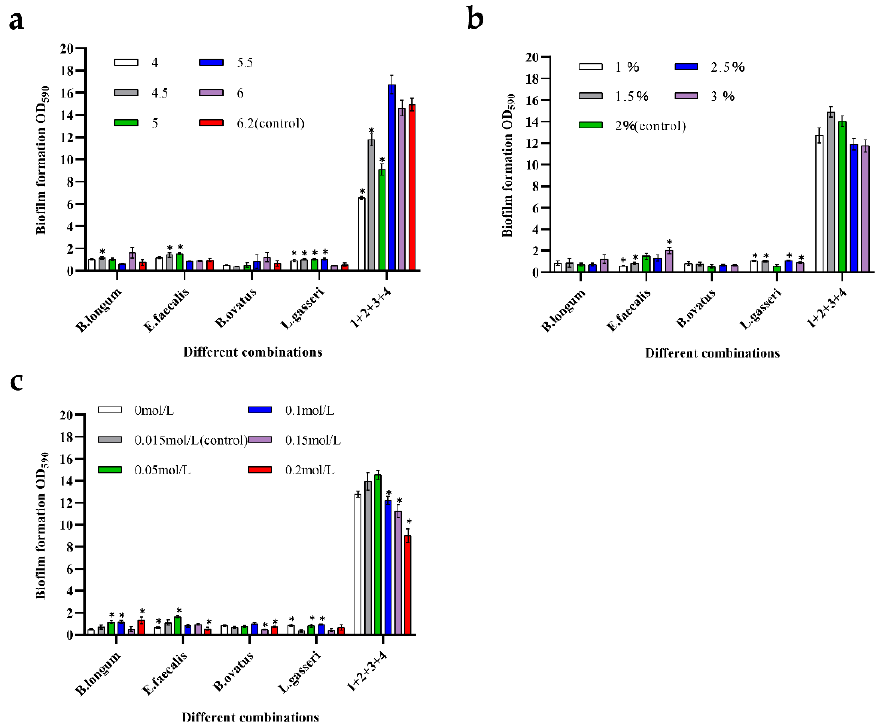
Figure 6. Formation ability of mono- and mixed-species biofilms when exposed to environmental stress. Numbers in these graphs from 1 to 4 represent the following strains: 1— B. longum FJND16M4, 2— E. faecalis E1, 3— B. ovatus FTJS5K9, and 4— L. gasseri FHNFQ11L7. Error bars in these graphs